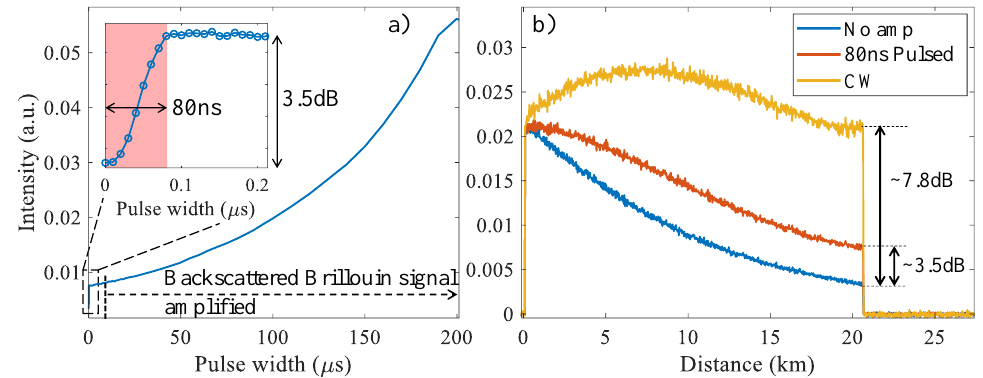
Figure 7. Optical intensity of the BOTDR signal collected before the MZI ( a ) at the end of the 20 km fiber as a function of the Raman pump pulse pulse-width (inset shows detailed view of the plot for very small pulse widths), and ( b ) when there is no Raman amplification, amplified by 80 ns-wide pulse and CW